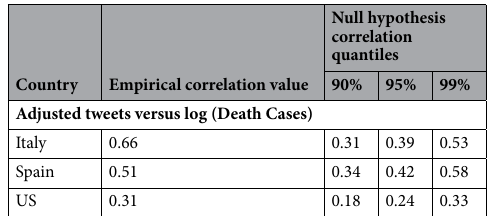
Table 2. Spearman’s rank correlation coefficient values for empirical values of each country and corresponding null-models significance levels.